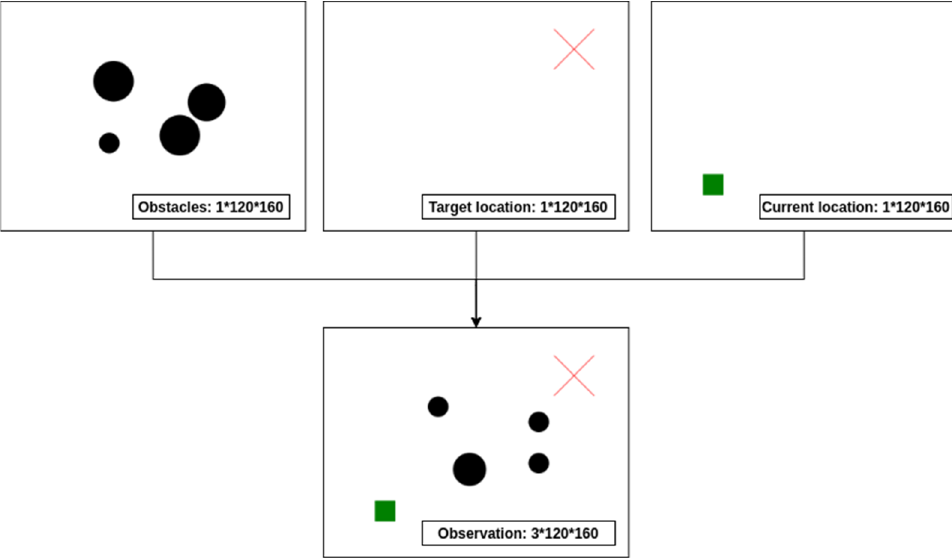
Figure 3. The generation of path planning global environment observation.